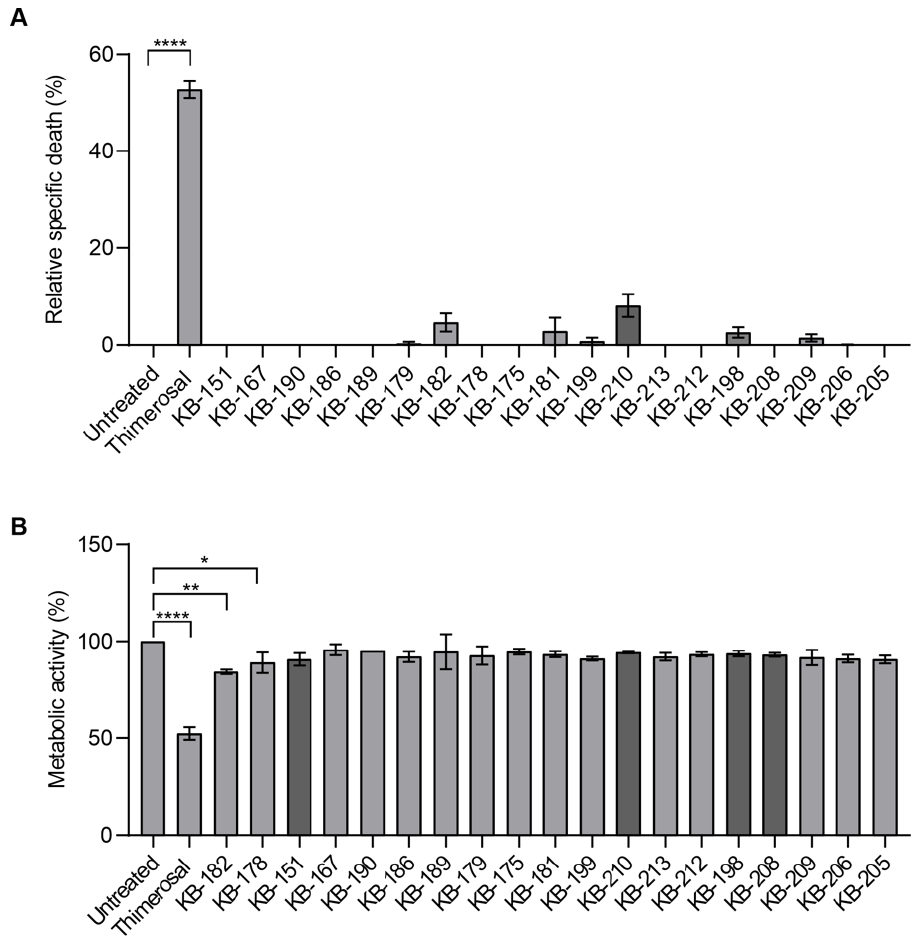
Figure 4. (A). LDH results: Y -axis shows the percentage of cell death. Thimerosal at 100 µM (**** p ≤ 0.0001) shows a significant difference compared to untreate d control. (B). MTT results: Y -axis shows the percentage of cell viability which relates to the cell metabolic activity. Thimerosal at 100 µM (**** p ≤ 0.0001), KB-178 (* p < 0.05) and KB-182 (** p < 0.005) show significant differences com- pared to untreated control. Bars represent the mean ± SD and N = 3. The four hit compounds are shown in a darker colour.